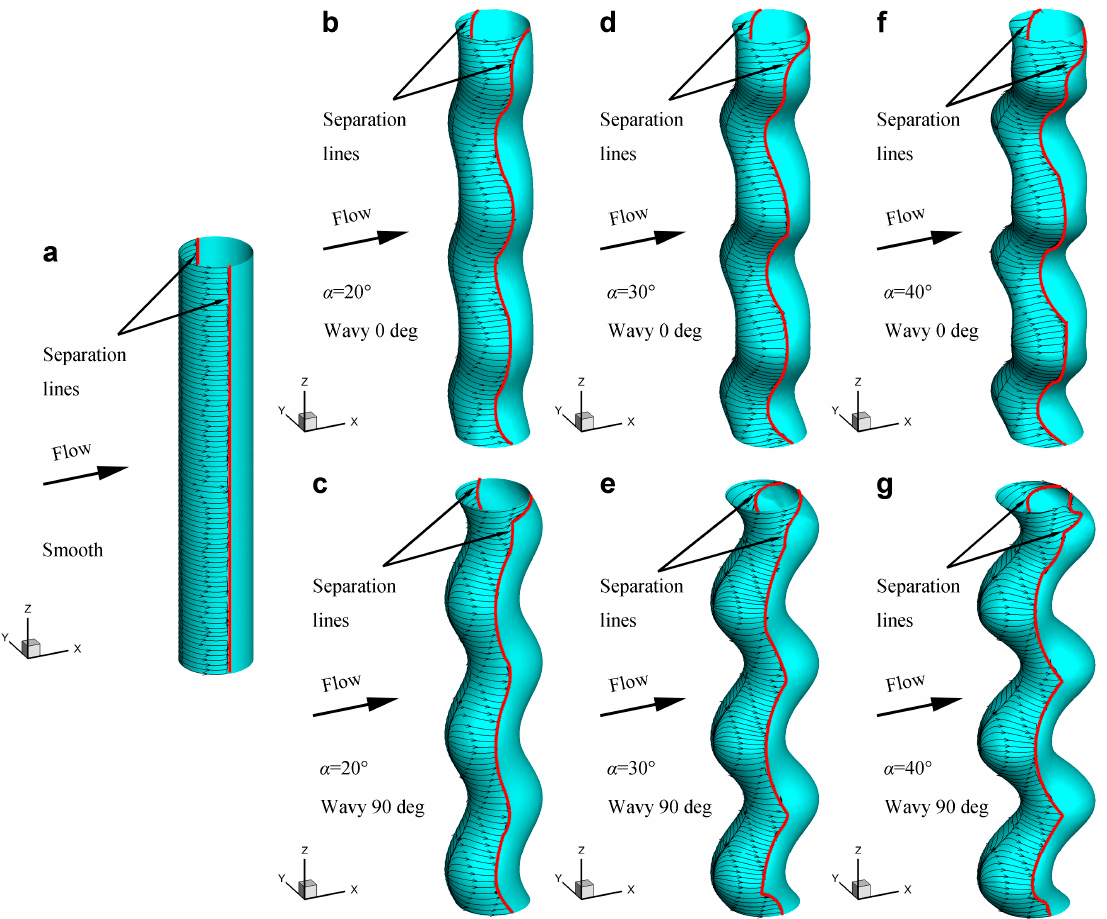
Figure 12. Three-dimensional separation lines of ( a ) the smooth cylindrical surface and ( b – g ) three wavy cylindrical surfaces.